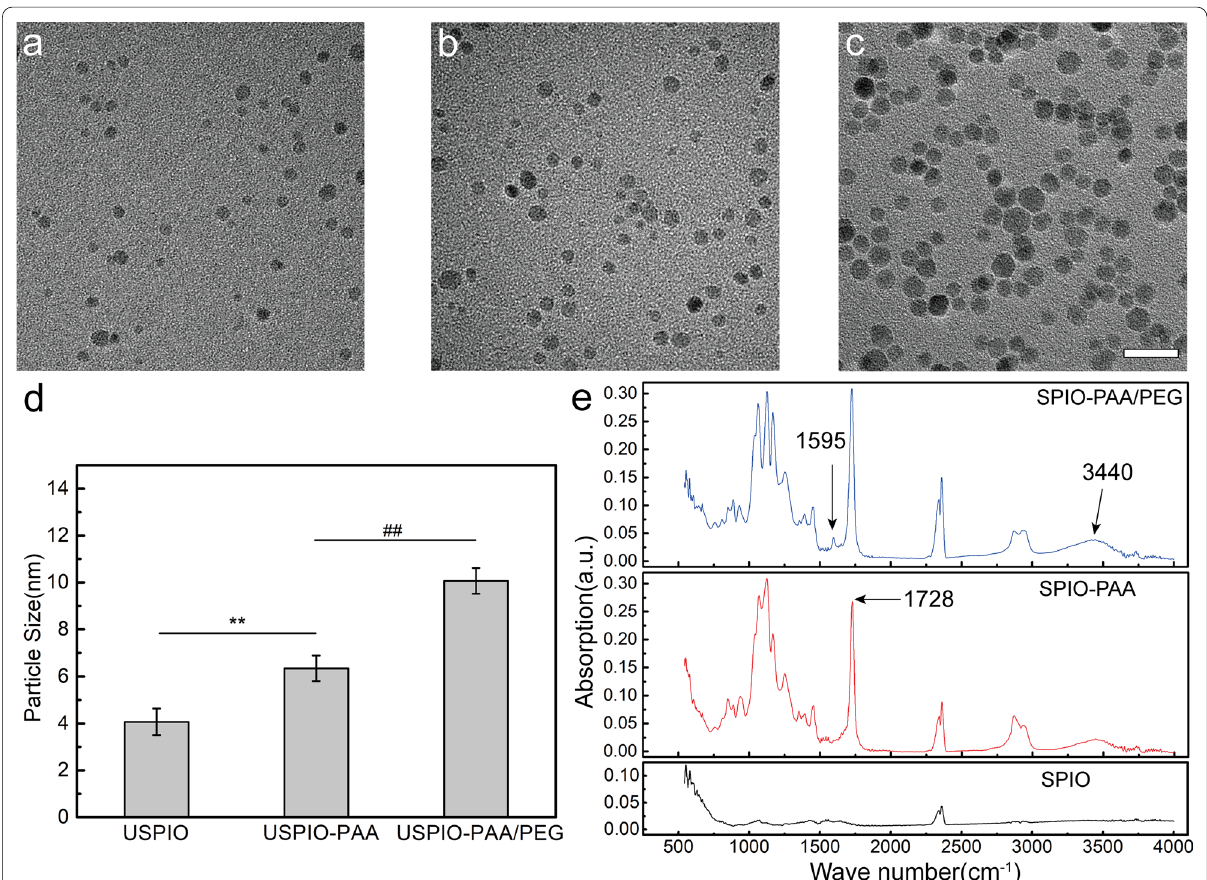
Fig. 2 Characterization of nanoparticles. a–c Representative TEM images of USPIO NPs ( a ), USPIO-PAA NPs ( b ) and USPIO-PAA/PEG NPs ( c ). d Statistical analysis indicated a significant difference among the particle size of USPIO, USPIO-PAA and USPIO-PAA/PEG ( n Fourier-transform infrared of nanoparticles of USPIO, USPIO-PAA and USPIO-PAA/PEG NPs. The arrows indicate the specific absorption peak at 1728 cm − 1 due to the PAA modification, 1595 cm − 1 and 3440 cm − 1 due to the PEG modification. Numerical data are presented as mean ** p < 0.01 versus the USPIO NPs, ## p < 0.01 versus the USPIO-PAA/PEG NPs. The bar represents 20